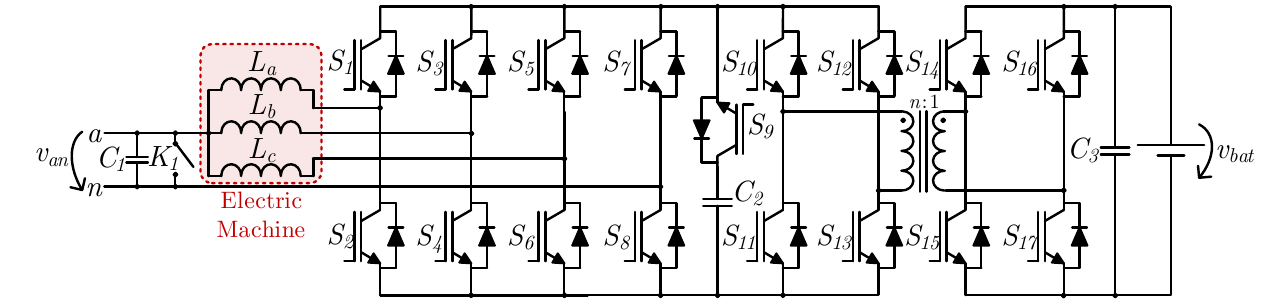
Figure 14. EV IBC with galvanic isolation proposed by Z. Wang et al. in 2020